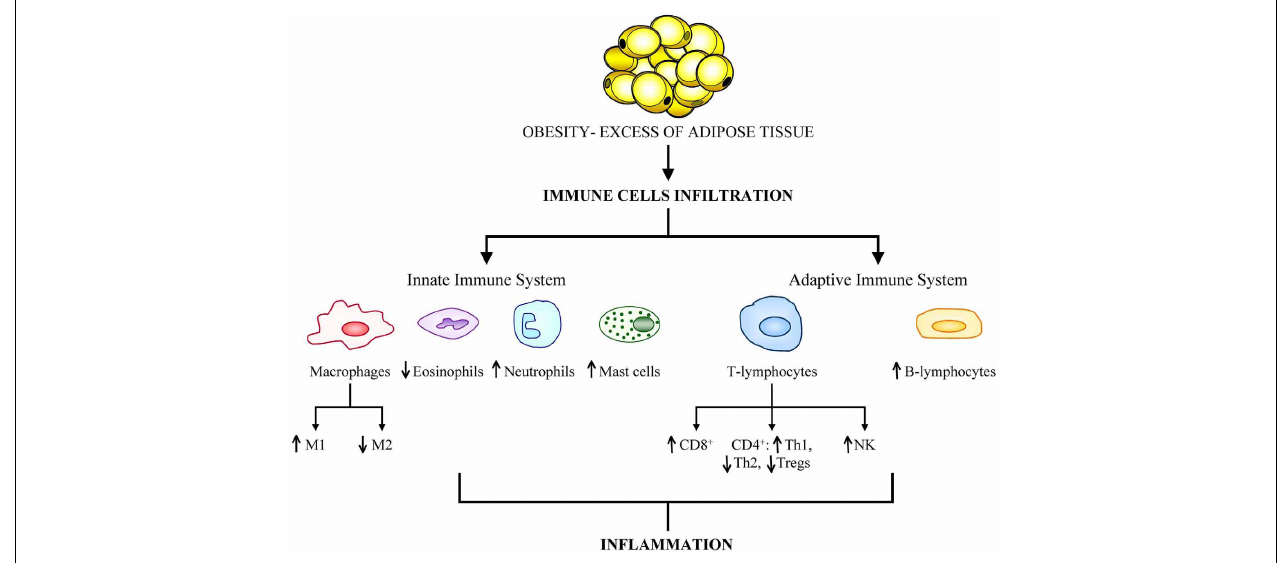
FIGURE 1 | Obesity is associated with a great infiltration of cells from both the innate and adaptive immune systems. The aberrant population expansion of these cells is related to the onset of obesity-related comorbidities, primarily cancer